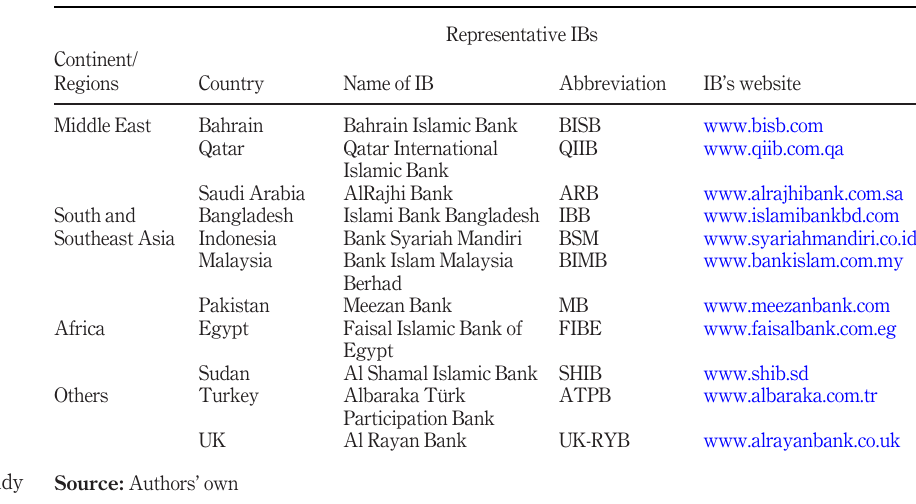
Table III. Sample of the study